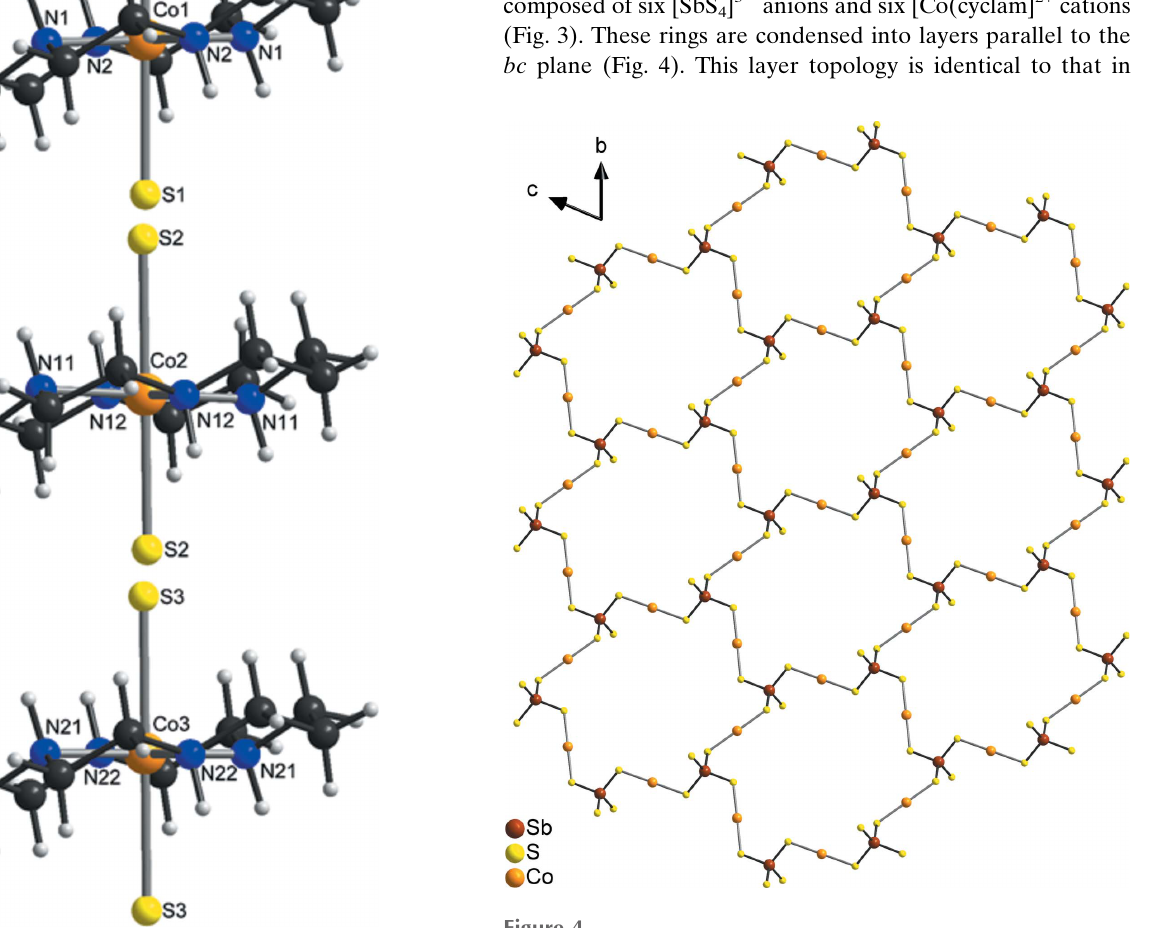
Figure 4 Crystal structure of the title compound with a view of the Co 3 (SbS 4 ) 2 network along the crystallographic a axis. The cyclam ligands are not shown for clarity.